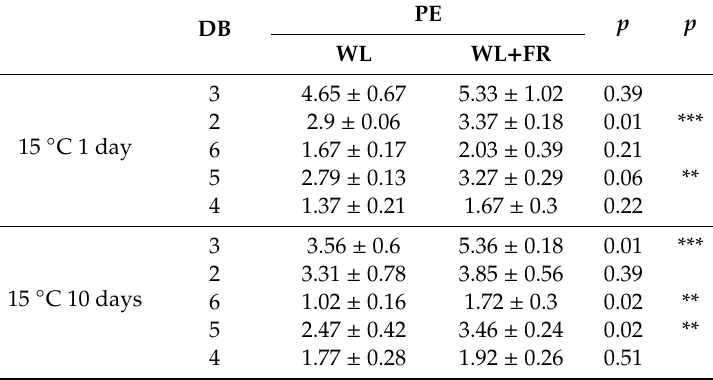
Table 4. PE species content in barley leaves grown at 15 ◦ C for 1 and 10 days and in leaves grown at 5 ◦ C for 1 and 7 days under WL and WL +